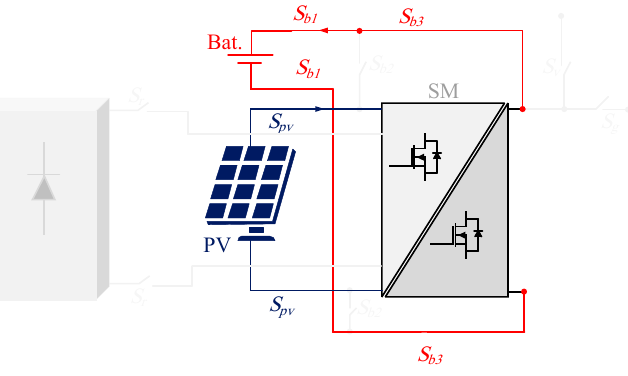
Figure 14. SM connection in Mode 2.